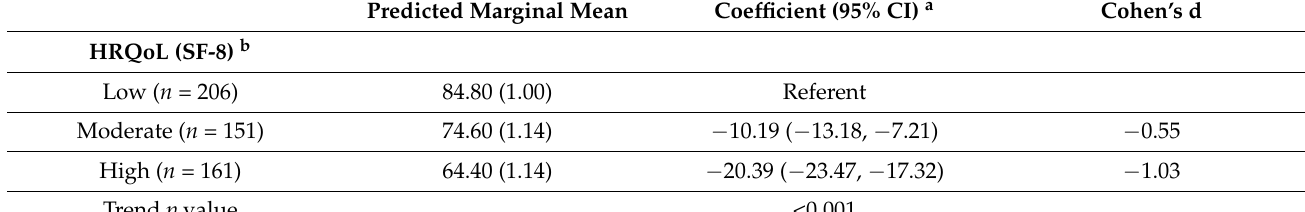
Table 2. Multivariable adjusted associations between COVID-19 impact (PCL-5), and HRQoL and psychological distress. Predicted Marginal